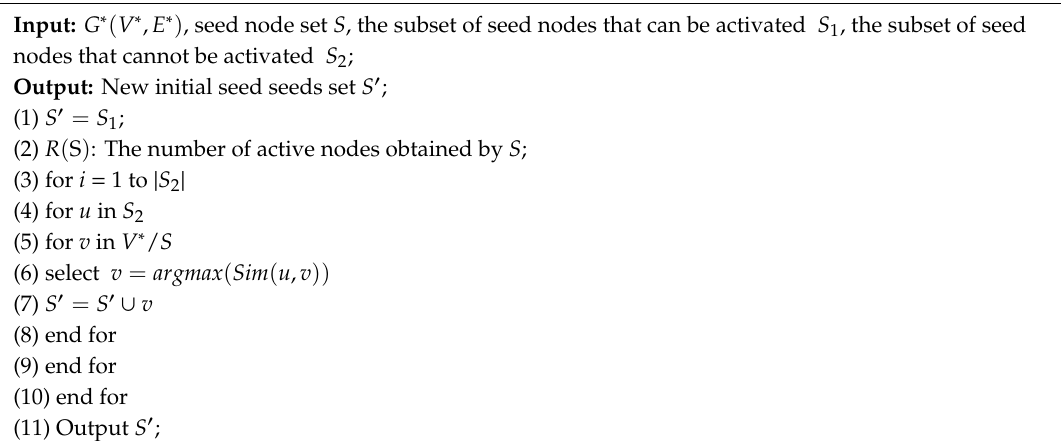
Algorithm 4. Similar-users-based Substitutes Mining Algorithm for SMMNIM